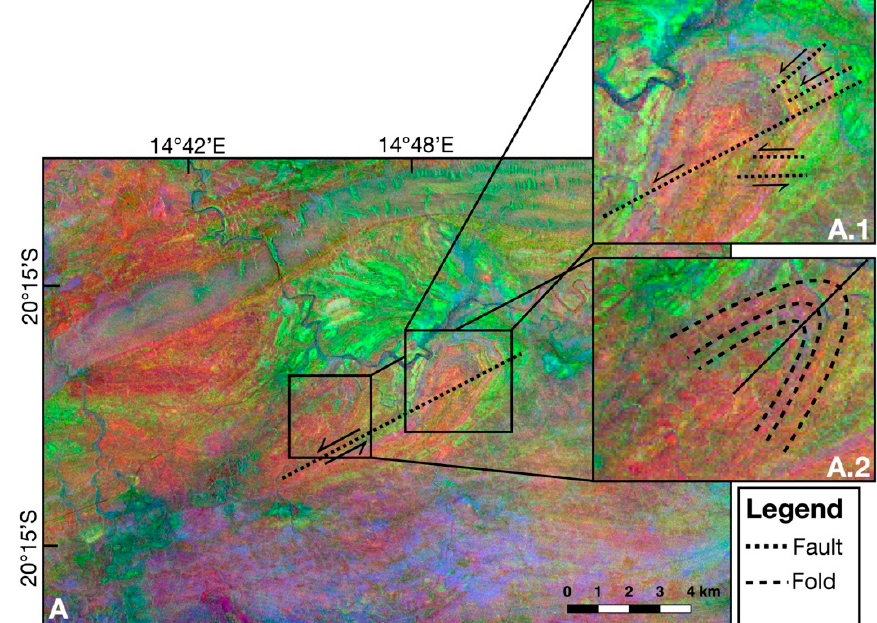
Figure 9. ( A ) False color composite of the band ratio results on ASTER data showing lithological discrimination (B4 / B7, B4 / B3, and B2 / B1). ( A.1 ) Major faults depicted. ( A.2 ) Indication of folding.